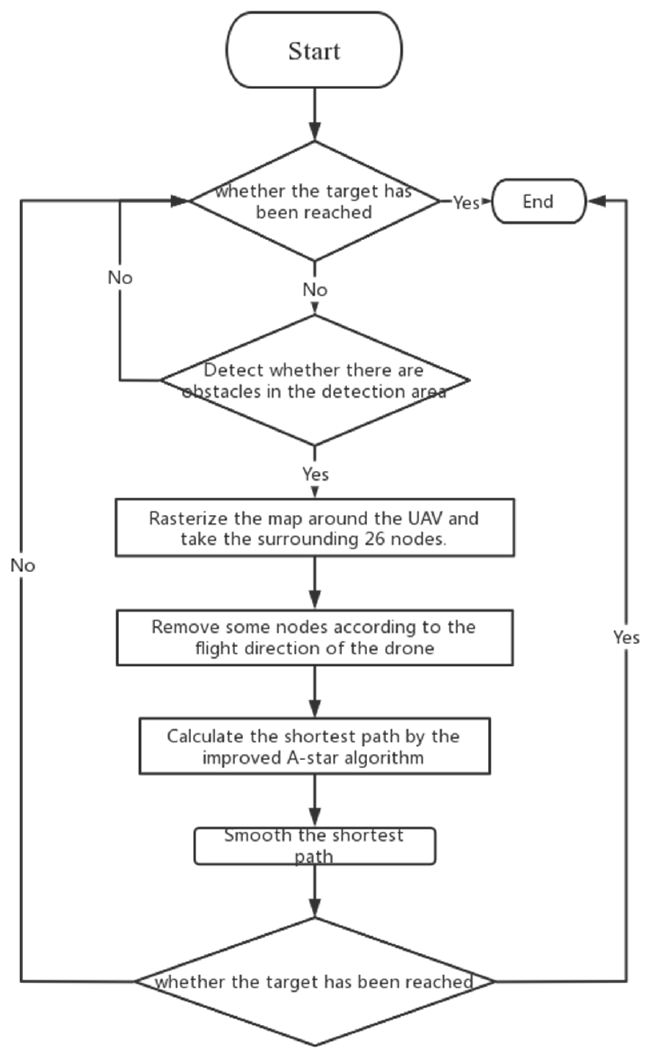
Figure 7. Improved algorithm flow based on A-star algorithm and